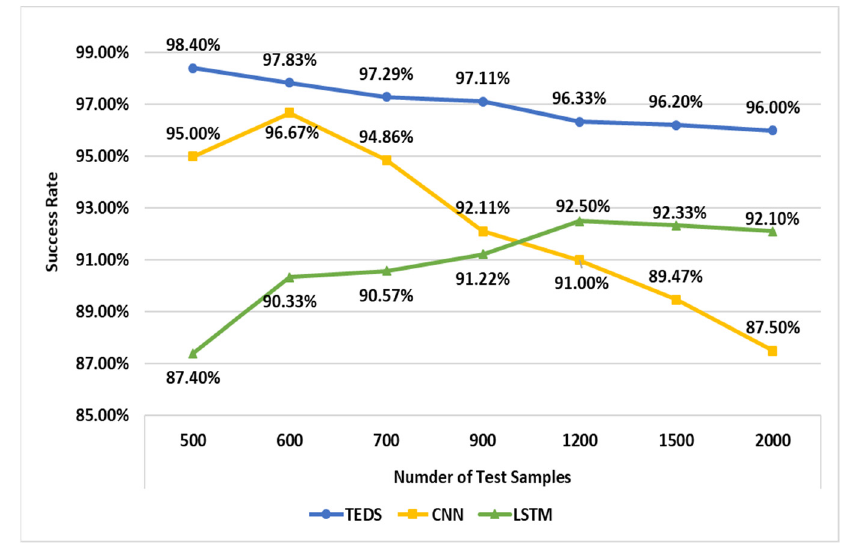
Figure 19. Graph of the diagnosis success rate according to the test samples.